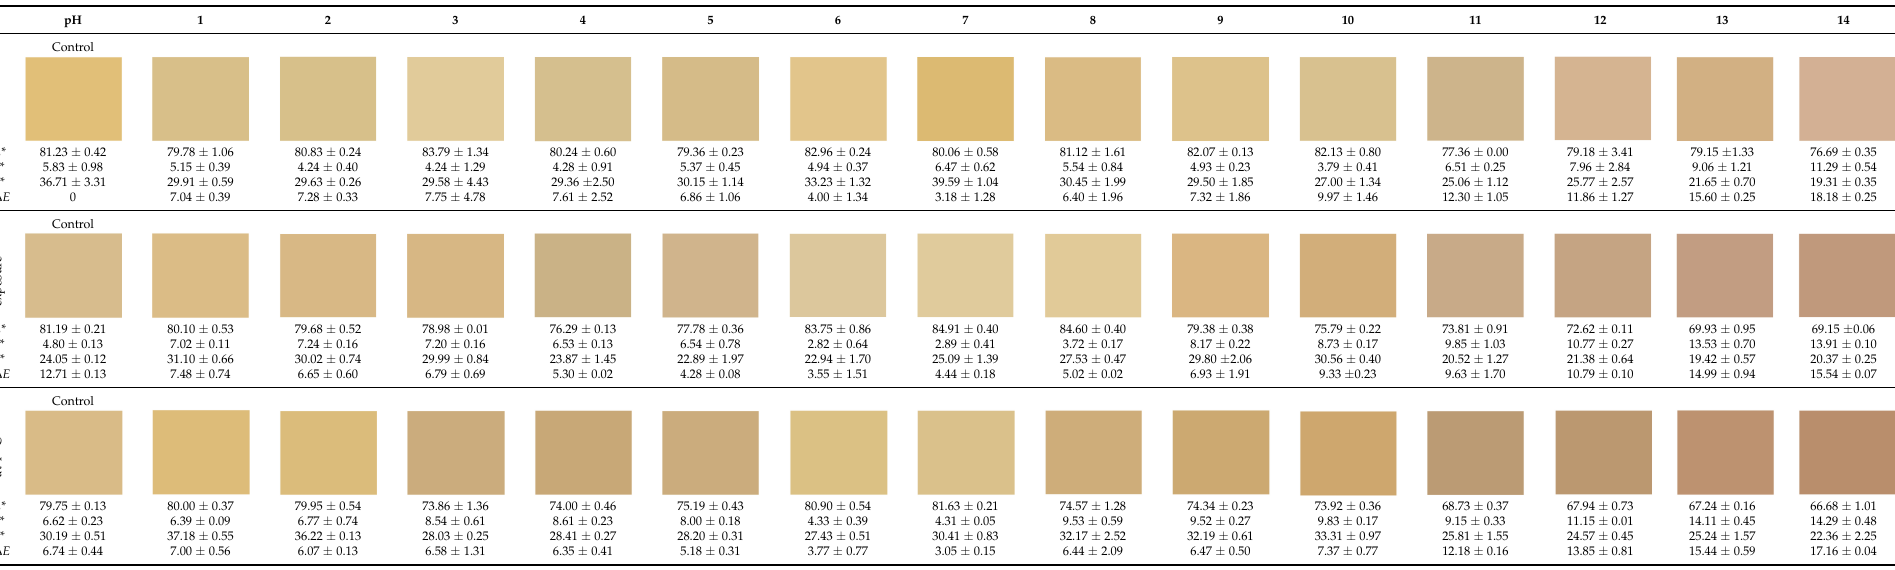
Table 7. Apparent color, colorimetric parameters, and total color difference ( ∆ E ) of the BC-flexirubin type pigment indicator at different pH values (1 to 14), first row contains initial values, second row contains the data obtained after light exposure (120 h), and the third row consist of data after storage at 4 ◦ C (120